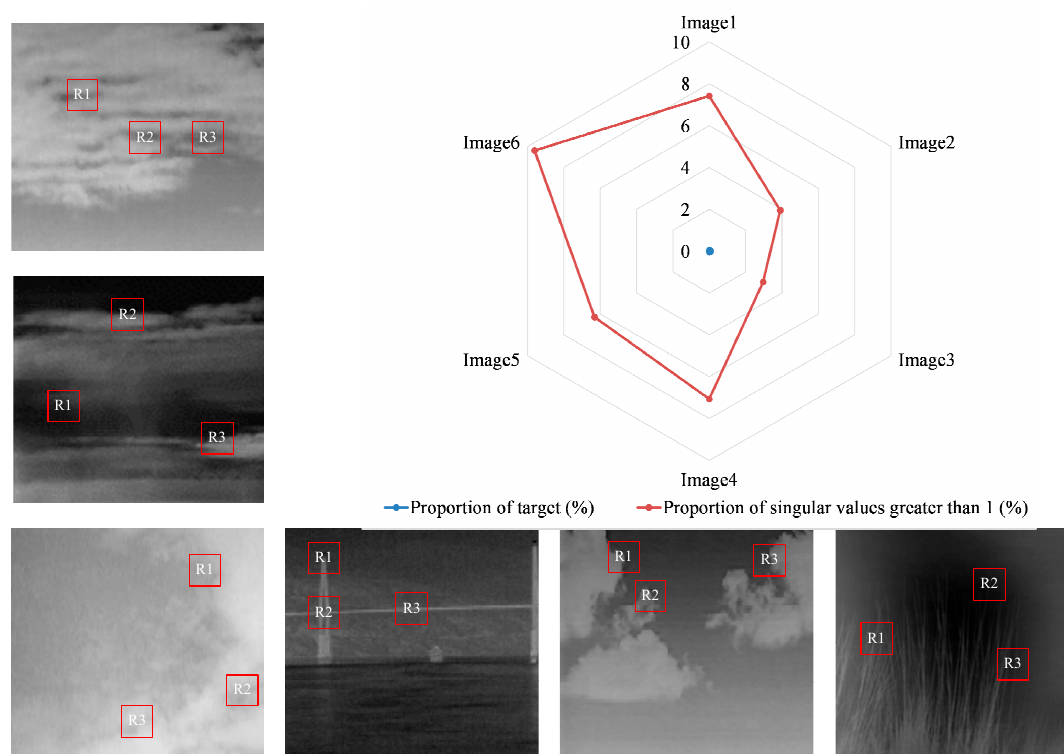
Figure 2. Illustration of low rank property and sparsity of infrared images.